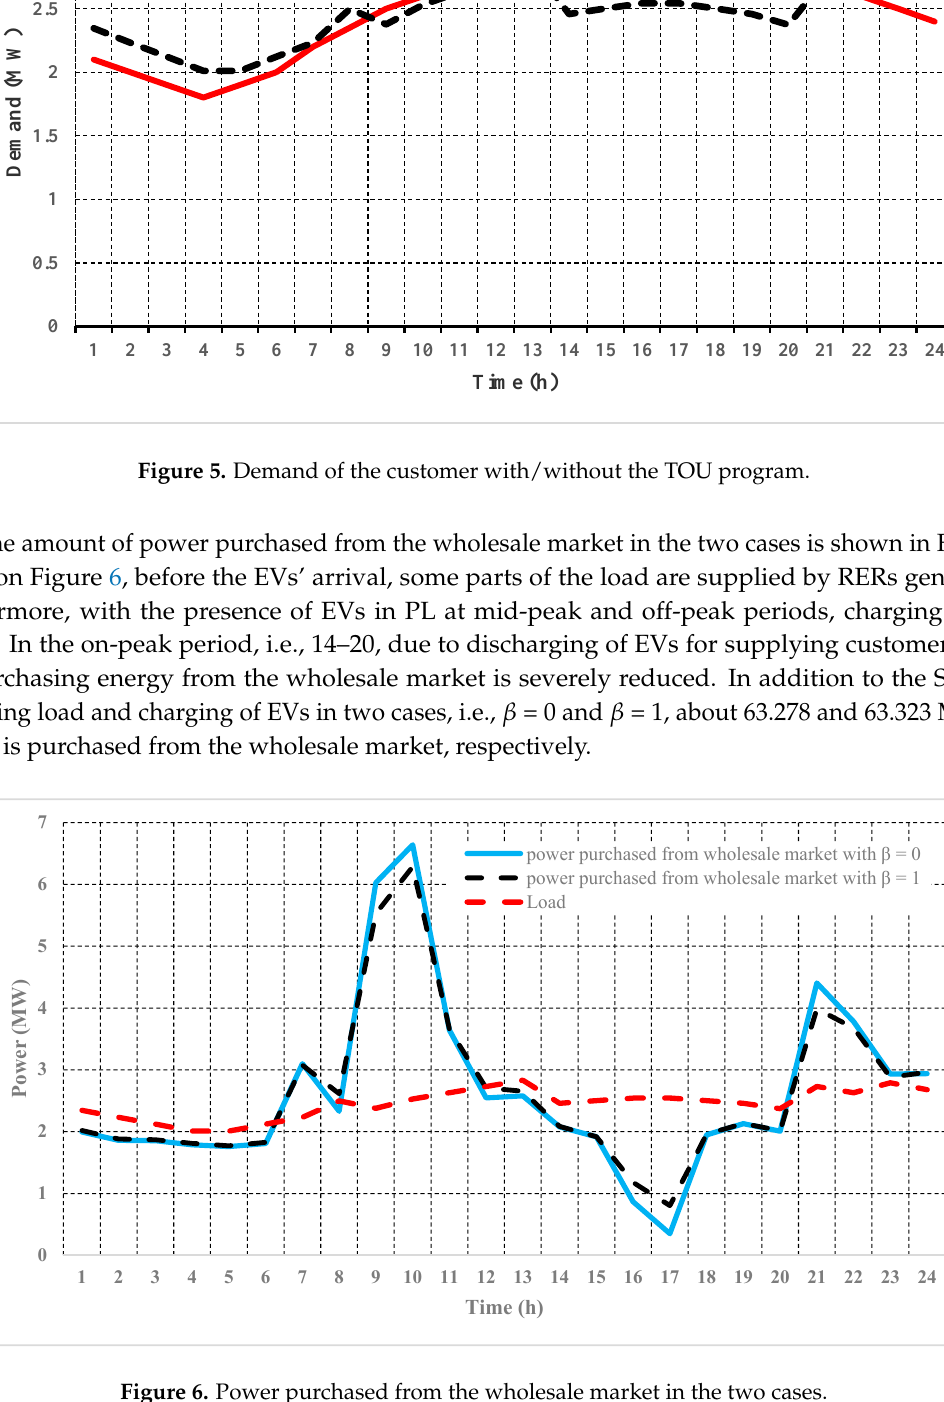
Figure 7 . Charging/discharging scheduling of 500 EVs.